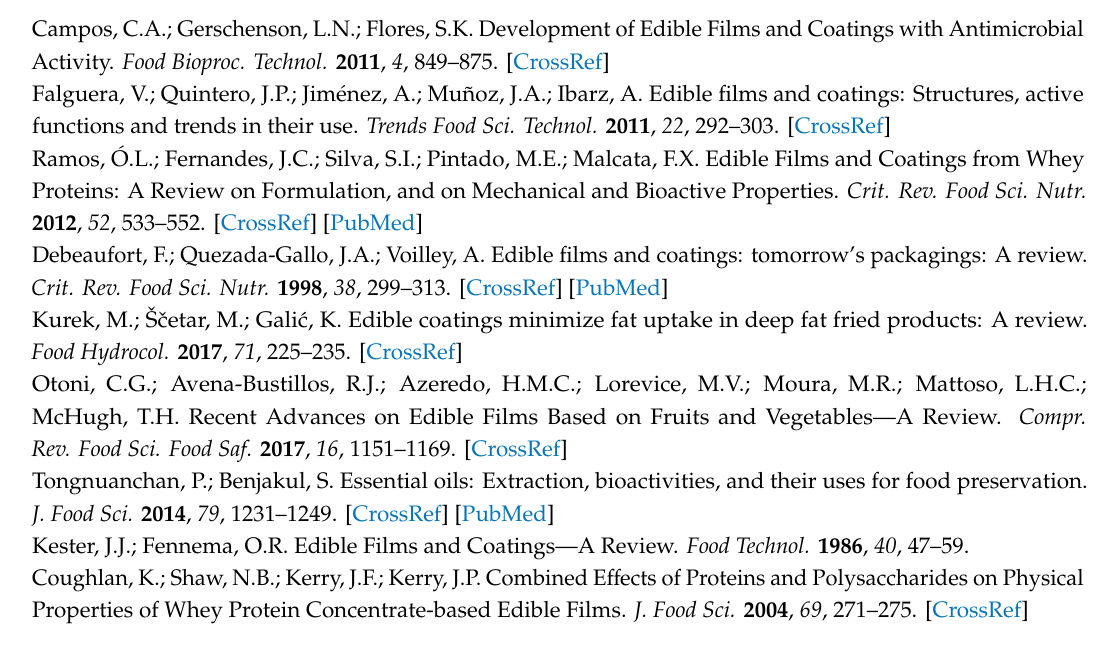
Figure S1: 3D surface plot of the e ff ects of components on pH of FFS where the region of A-WP interaction increased the solution pH and Pectin decreased the pH; Figure S2: 3D surface plot of the e ff ects of components on opacity of edible films where the interaction of WP with P / A increased the opaqueness; Figure S3: 3D surface plot of the e ff ects of components on water contact angle ( θ ) of edible films where the blending of WP / P / A results in higher convexity indicating improved hydrophobcity of films; Figure S4: 3D surface plot of the e ff ects of components on moisture content (%) of edible films; Figure S5: Representative plots of viscosity (vs.) shear rate for selected formulations S1 (1:1:1); S2 (3:0:0); S6(0:0:3) and